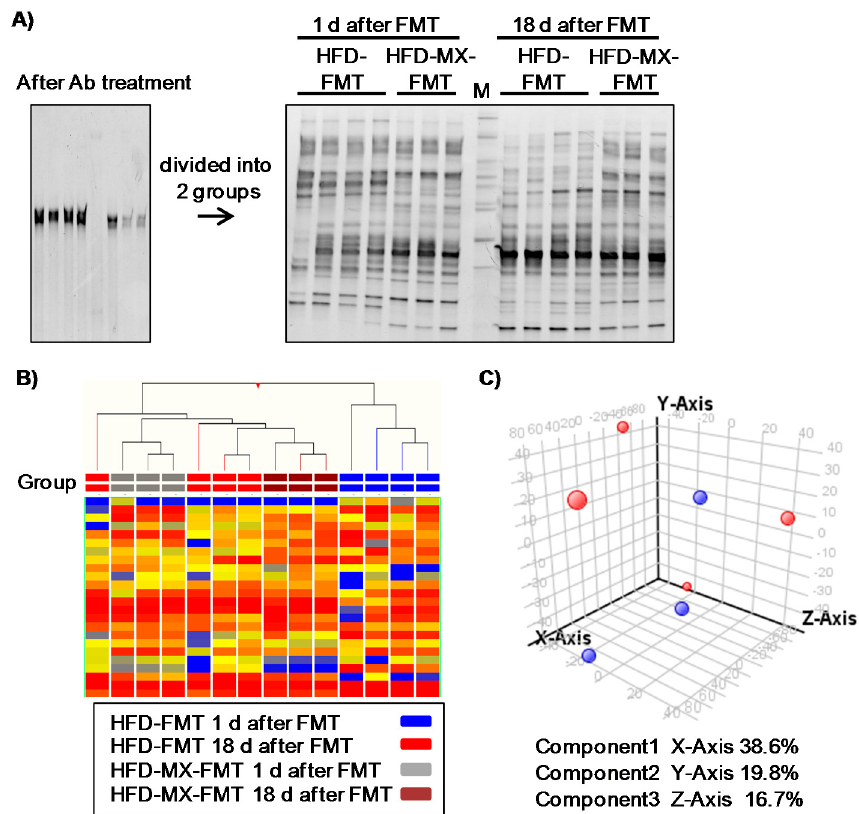
Figure 4. Changes in fecal microbiota and luminal metabolites of recipient mice in fecal transplantation experiment. Fecal transplantations were performed from donor mice fed the HFD with or without xylitol to antibiotic (Ab)-treated recipient mice (HFD-FMT and HFD-MX-FMT). Band patterns ( A ) and hierarchical clustering of band patterns ( B ) in feces 16S V2–V3 rRNA composition in HFD-FMT and HFD-MX-FMT mice. Ab treatment reduced fecal bacteria (left band pattern) and gradual changes in the composition of fecal bacteria in the HFD-FMT and HFD-MX-FMT mice from 1 day after FT to 18 day after FMT. M: Marker. Principle component analysis of luminal metabolites in HFD-FMT (red) and HFD-MX-FMT mice (blue). ( C ). n =